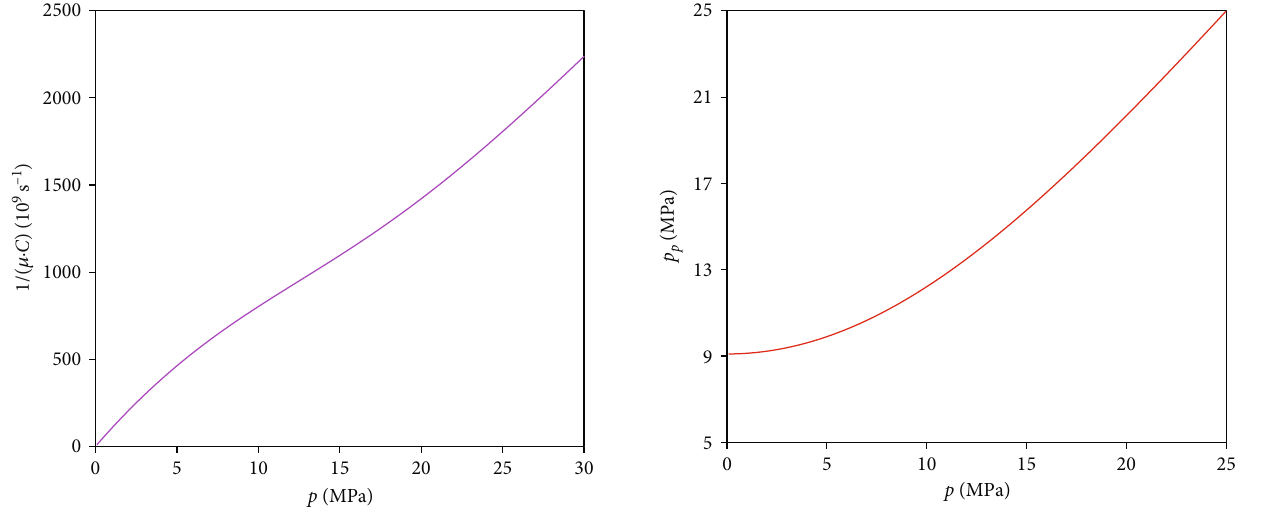
Figure 5: The relation curve of p